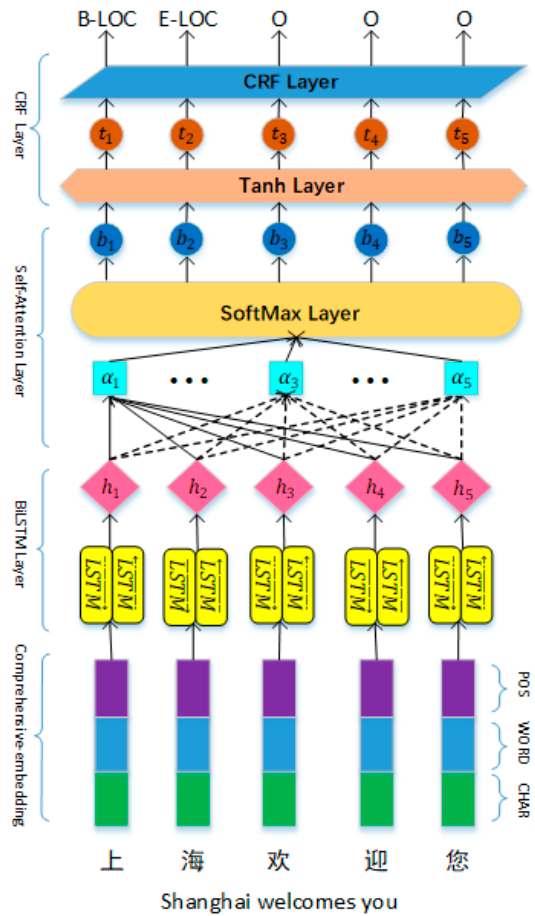
Figure 1. The overall structure of Character-Word-Position Combined Bidirectional Long Short Term Memory-Attention (CWPC_BiAtt) is divided into four layers: (1) comprehensive-embedding, which is composed of character-embedding, word-embedding, and position-embedding. (2) Bidirectional Long Short Term Memory (BiLSTM) layer, the role of this layer is to capture historical information and future information in the sentence of this paper. (3) self-attention layer captures the connection between several arbitrary positions in the sentence, using softmax to normalize the value output by attention-mechanism. (4) conditional random field(CRF) layer first uses tanh function to quickly change the gap between features, and then uses CRF for marking. B in B-LOC means Begin, LOC means location, E in E-LOC means end, and LOC means location.